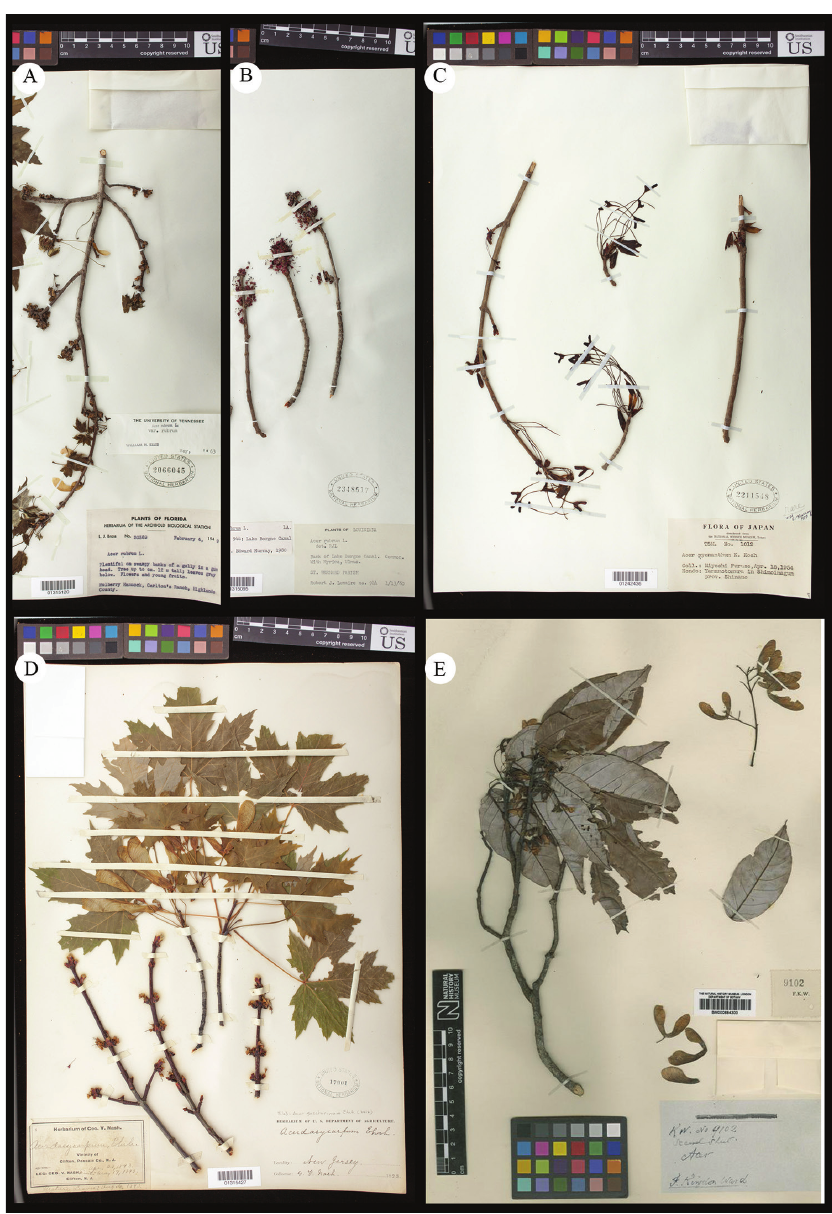
Figure 9. Inflorescences of Acer sects. Rubra and Hyptiocarpa . A Acer rubrum with umbels of pistilate flowers B Acer rubrum with umbels of staminate flowers C A. pycnanthum with umbels of pistilate flowers C A. saccharinum with umbels of pistilate flowers. Note flowers with two, divided persistent styles D A. pinnatinervium with racemose thyrse. Specimens in A–D deposited at US, and specimen in D deposited at the British National Museum (BM). Accession information visible in images, and detailed specimen records are available via the US online catalog (http://collections.nmnh.si.edu/search/botany/) and at the data portal of BM